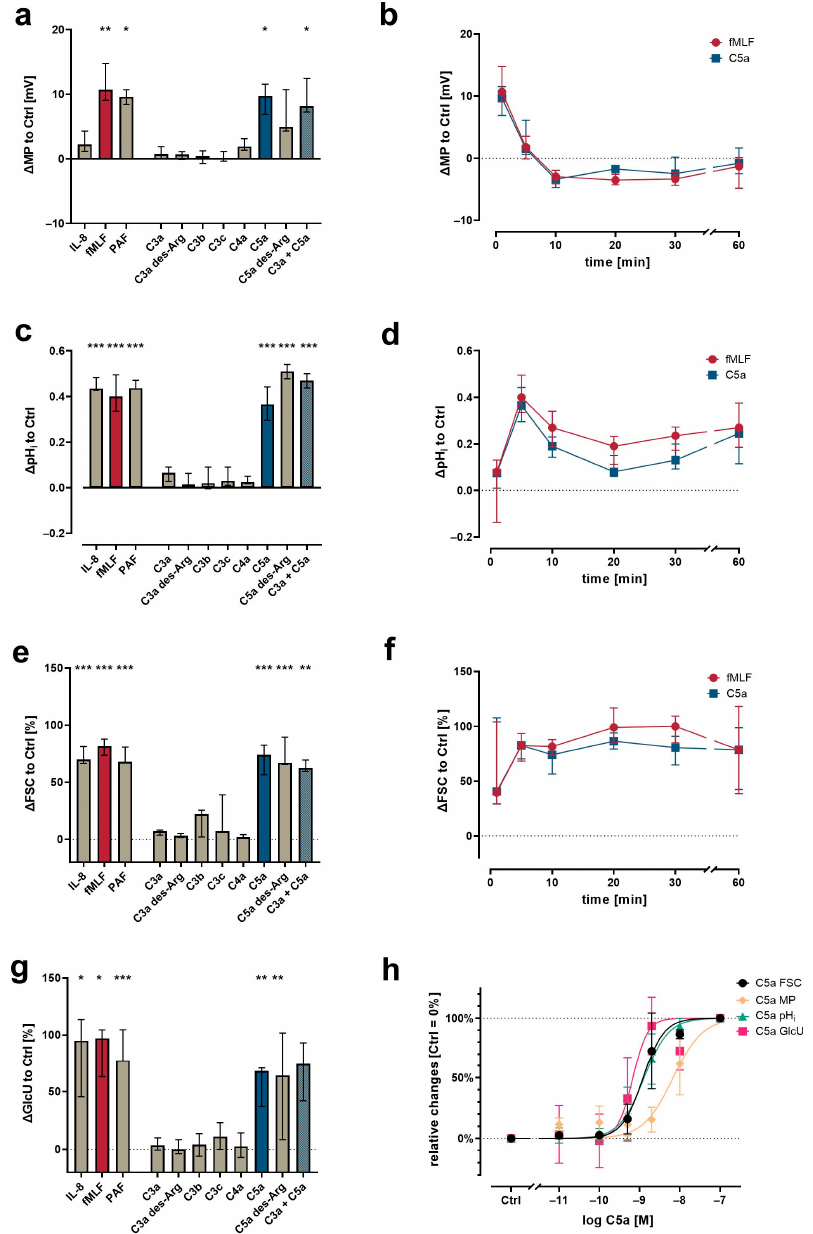
Figure 3. Neutrophil physiological response upon exposure to complement cleavage products with respect to changes ( a ) of membrane potential (MP, measured by change in DiBAC 4 (3) fluorescence) 1 min after stimulation, ( c ) intracellular pH (pH i , measured by change in SNARF fluorescence) 5 min after stimulation, ( e ) cellular shape as indicated by FSC 10 min after stimulation, and ( g ) glucose uptake (GlcU, measured by change in 2NBDG fluorescence) as measured after 10 min of stimulation. Time curves summarize for the change in ( b ) MP, ( d ) pH i , and ( f ) cellular shape. ( h ) Summary of the concentration-dependency of the C5a-induced effects. Results are normalized to unstimulated neutrophils (= 0% or 0). The following concentrations were used: 10 nM C5a, 10 nM C5a des-Arg, 10 µ M fMLF, 50 ng/mL IL-8, 100 nM C3a, 100 nM C3a des-Arg, 100 nM C3b, 100 nM C3c, or 100 nM C4a. n = 6–8, median ± interquartile range. *, **, and *** = p < 0.05, < 0.01, and < 0.001,